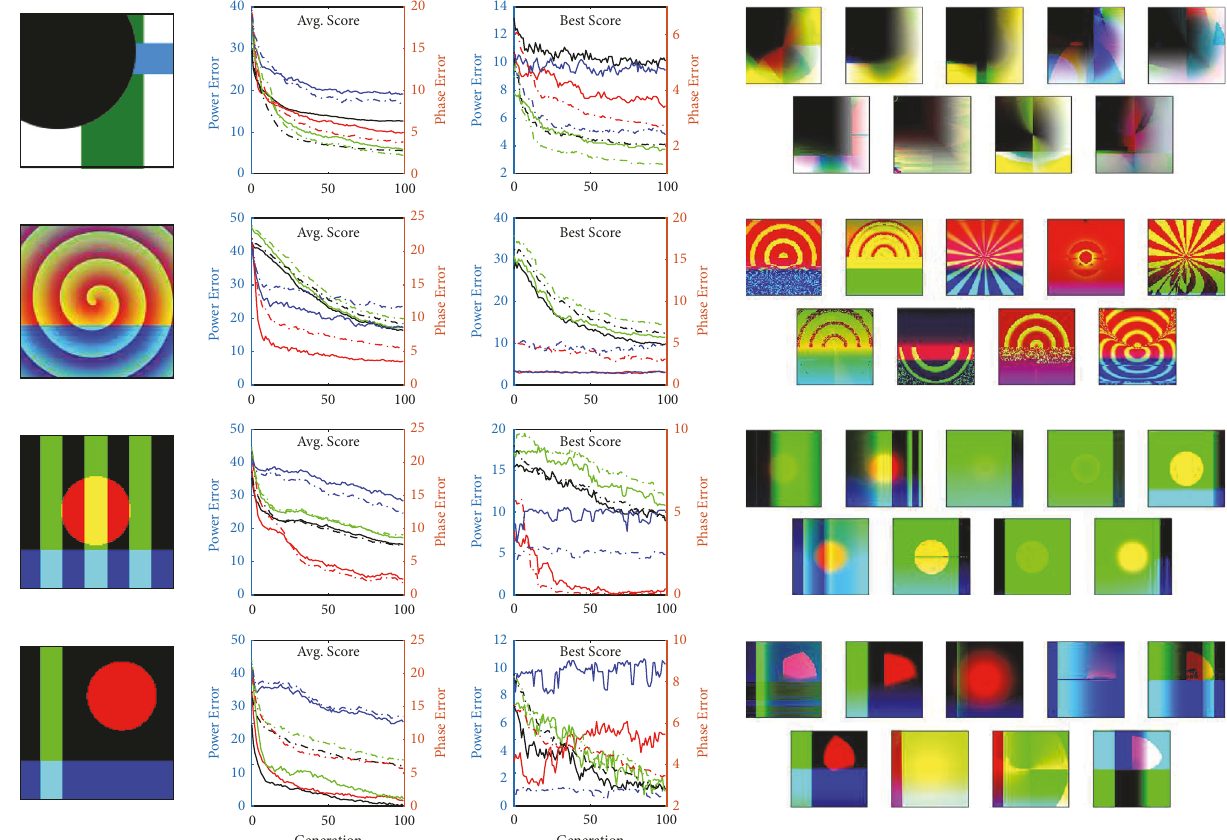
Figure 13: Colour experiment summary charts and examples. Power and phase errors for each of the red, green, and blue colour channels are plotted with their respective colour. Errors considered across the average luminance have been plotted in black. Power error is denoted with solid lines, where phase error uses a dashed line.